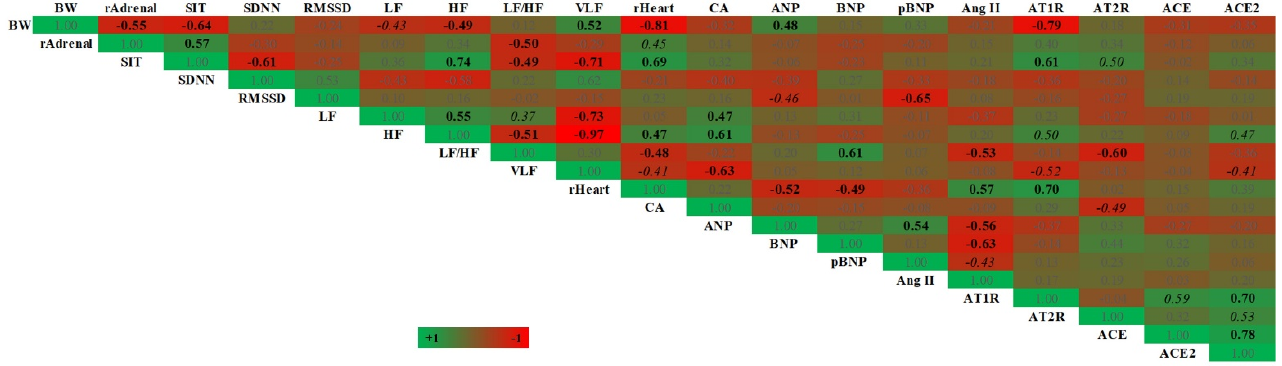
Figure 7. Correlative analysis between stress-, HRV-, cardiac- and RAAS-related indices. The correlative values are shown with the gradient color of green to red ranging from +1 to − 1; numbers in bold and italic represent p < 0.05 and 0.05 < p < 0.10, as determined by Pearson correlation; n = 13–14. Abbreviations: BW, body weight; CA, cardiomyocyte area; pBNP, plasma BNP; rAdrenal, relative adrenal gland weight; rHeart, relative heart weight; SIT, normalized sucrose intake test.